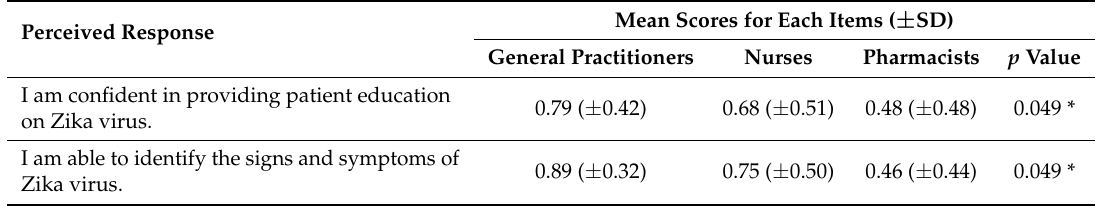
Table 3. Healthcare professionals’ perceived response for Zika